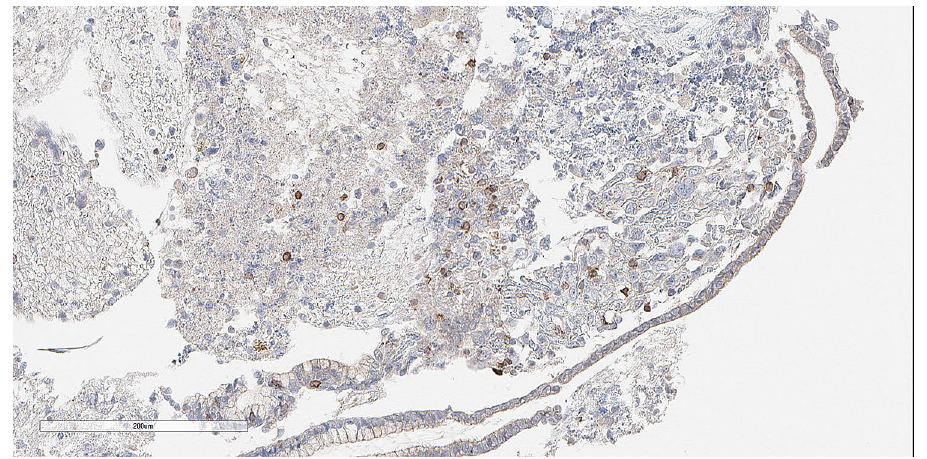
Figure 3. Photomicrograph on an immunohistochemistry stained case of gallbladder adenocarcinoma in a 63-year old man showing low positive staining results for anti-PD-L1 in intratumoral immunocytes. This tumor featured an ERBB2 extracellular domain S310Y mutation. (peroxidase-anti-peroxidase X